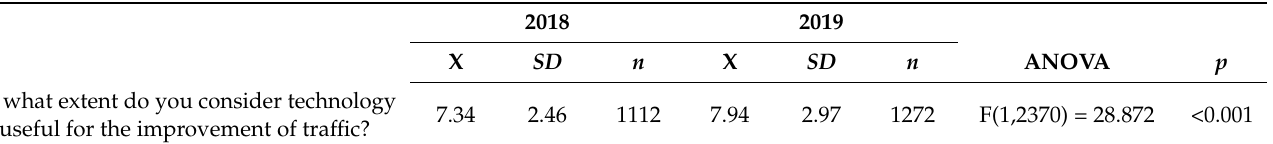
Table 3. Level of perception of the usefulness of technologies in the improvement of traffic.